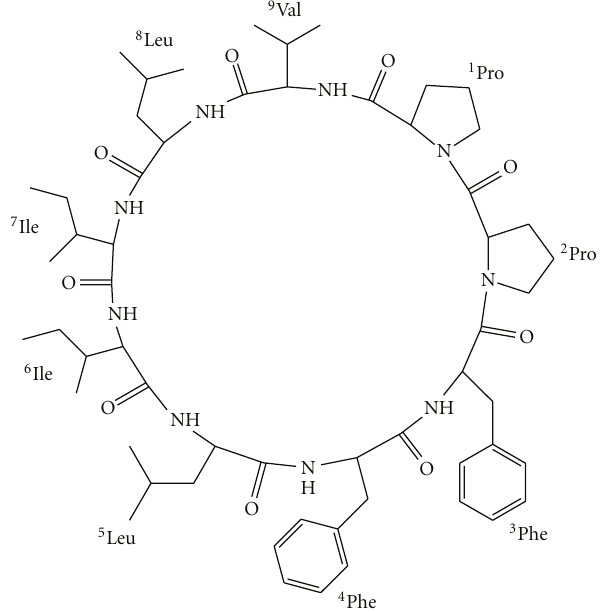
Figure 1: The structure of cyclolinopeptide A.